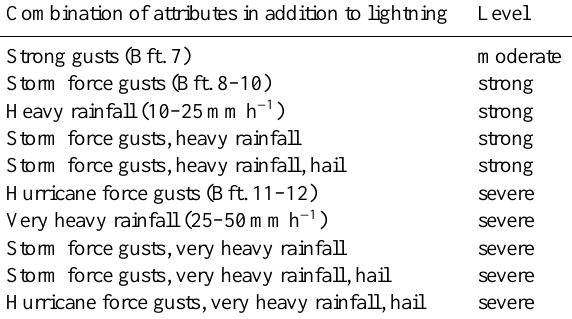
Table 1. Overview of DWD warning criteria related to thunder-